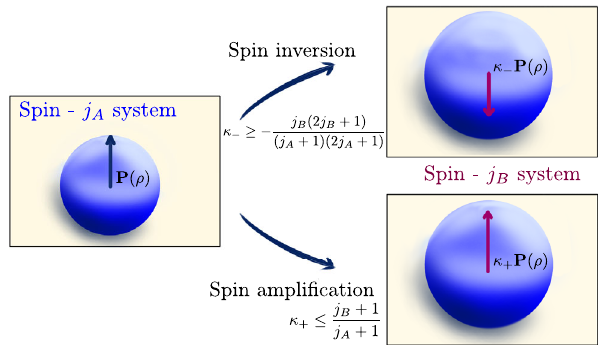
FIG. 2. Spin inversion and amplification. There exist quantum channels that can invert or amplify the polarization of a spin system while exactly respecting SU(2) rotational symmetry. The values κ provide the ultimate limits of such processes and (cid:3) depend only on the dimension of the spin systems involved.